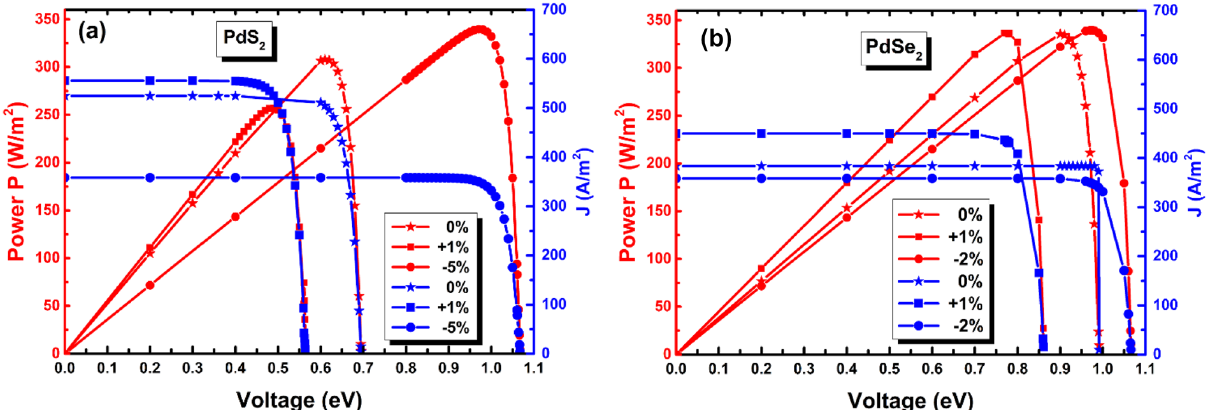
Figure 7. The calculated J − V characteristic and power density curves of ( a ) for penta- PdS 2 and ( b ) for penta- PdSe 2 for pristine and compressive (- ε % ) or tensile (+ ε % )) loaded strain (maximum efficiency η ( ε % ) of strain taken) at T = 300 K.